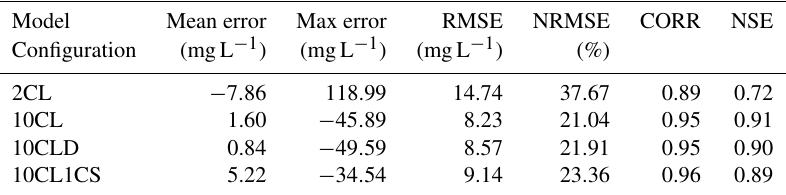
Table 2. Model performances computed for a 14d simulation period (1–14 March 2017). NRMSE is the normalized root-mean-square error, and CORR is